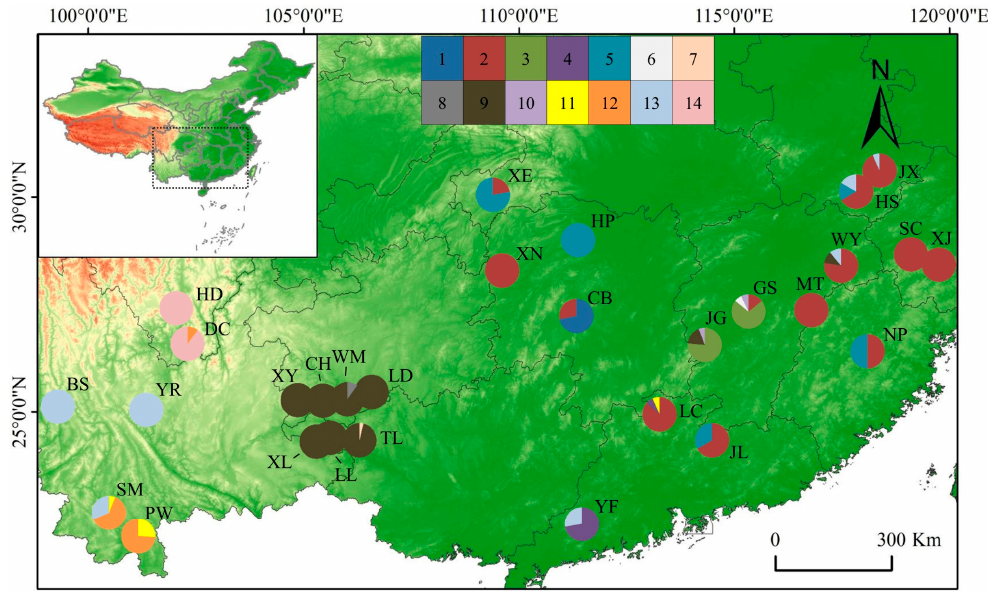
Figure 1. A map shows the twenty-nine sample sites and the geographic distribution of the mtDNA haplotypes that were derived from concatenated sequences of cox 1 − nad 1 and 26S − rRNA − tRNA − Leu. Pie charts show different proportions of haplotypes within each of 29 populations of T. ciliata complex. H i ( i = 1,2, . . . , 14) represents the i th haplotype. Each of fourteen colors in pie charts represents one haplotype (H1–H14).